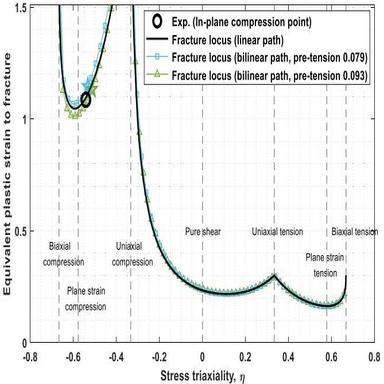
Verification of fracture loci by bilinear strain paths with a monotonic in-plane compression test point and a linear strain path-based fracture locus.